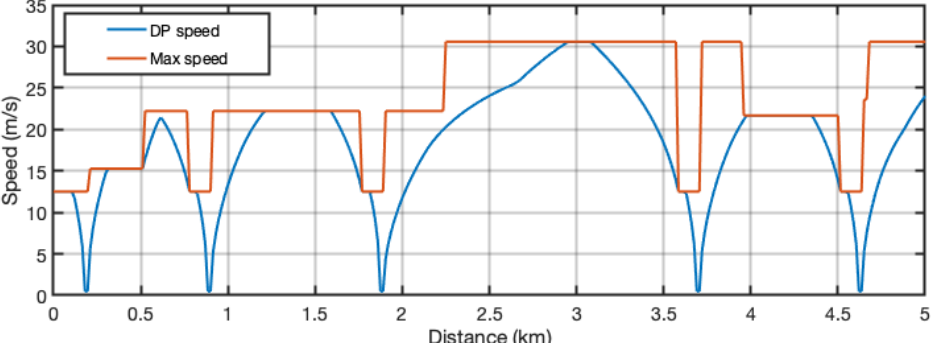
Figure 3. Maximum driving speed in compliance with speed limits.